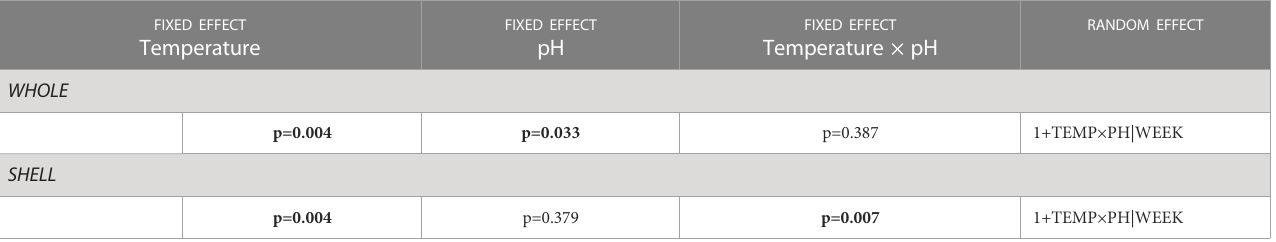
TABLE 4 Structure of fi nal linear mixed effects models for N 2 O production [nmol N 2 O ind -1 h -1 ] by whole animals [ WHOLE ] and shell bio fi lms [ SHELL ]: signi fi cance of fi xed effects Temperature (TEMP), pH (PH) and two-way interaction (TEMP x PH), and identity of random effects, including random intercept (format = 1|random) and potential random slope (format = 1+ fi